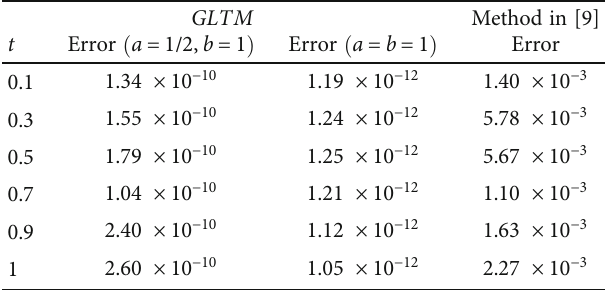
Figure 3: Absolute error for Example 5. Table 3: Comparison of the MAEs of Example 6 for M = 4